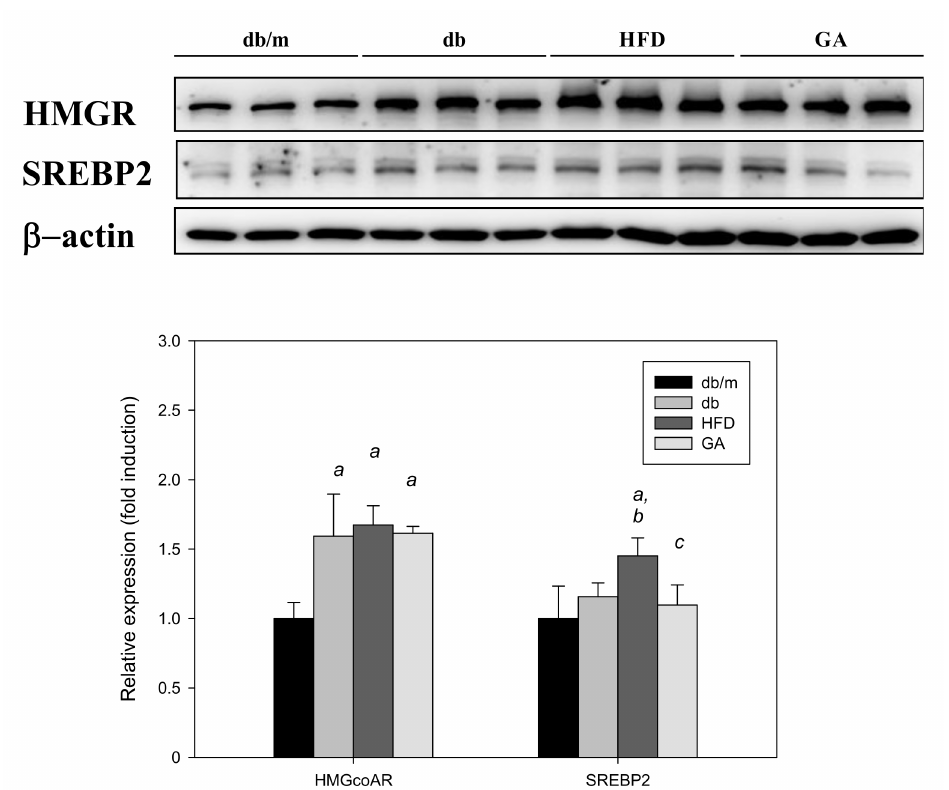
Figure 5. HFD induced the expression of cholesterol synthesis–related proteins and GA inhibited SREBP2 expression in diabetic mice. The 6-week-old male db/db mice were fed with HFD and 100 mg/kg GA for 12 weeks. After euthanization, liver tissue samples were obtained for determina- tion with SREBP2 and HMG-CoA reductase antibodies. db/m, age-matched heterozygous mice fed with standard diet; db, db/db mice fed with standard diet; HFD, db/db mice fed with HFD; GA, db/db mice fed with HFD and GA. a, p < 0.05 compared with the db/m control group. b, p < 0.05 compared with the db group. c, p < 0.05 compared with the HFD